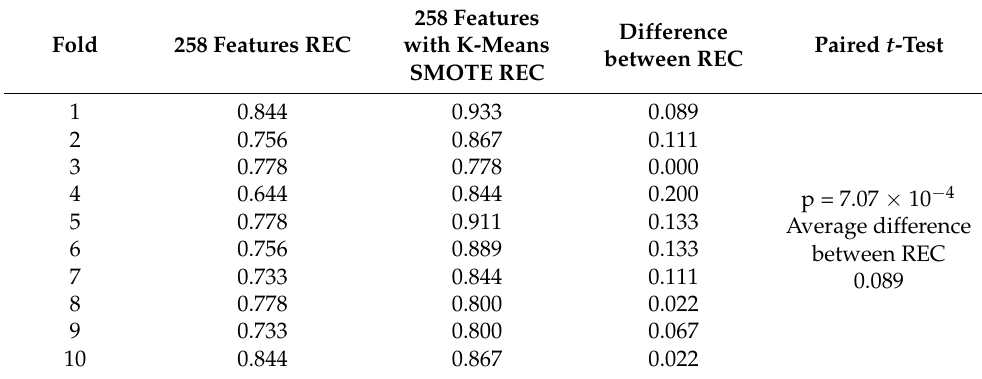
Table 8. Paired t -test of recall for 258 features w/wo K-Means